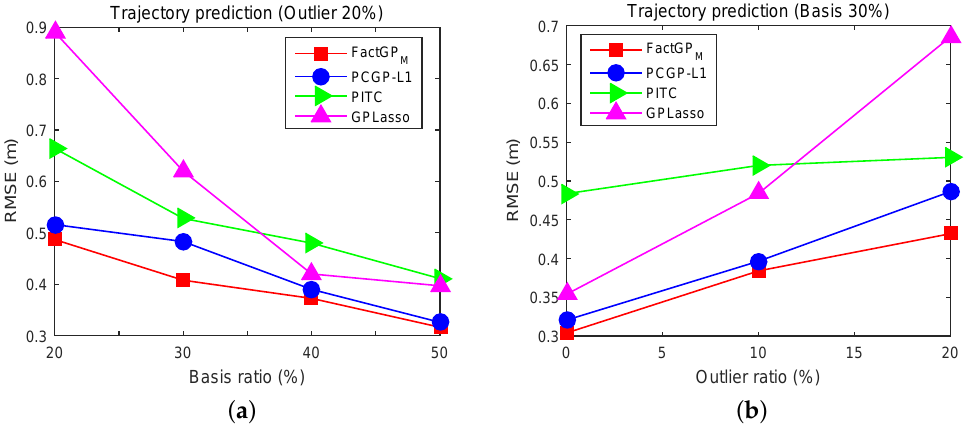
Figure 5. Motion prediction results based on human trajectories with respect to: ( a ) various basis ratios in the existence of 20% outliers; and ( b ) various outliers while 30% basis ratio is fixed.